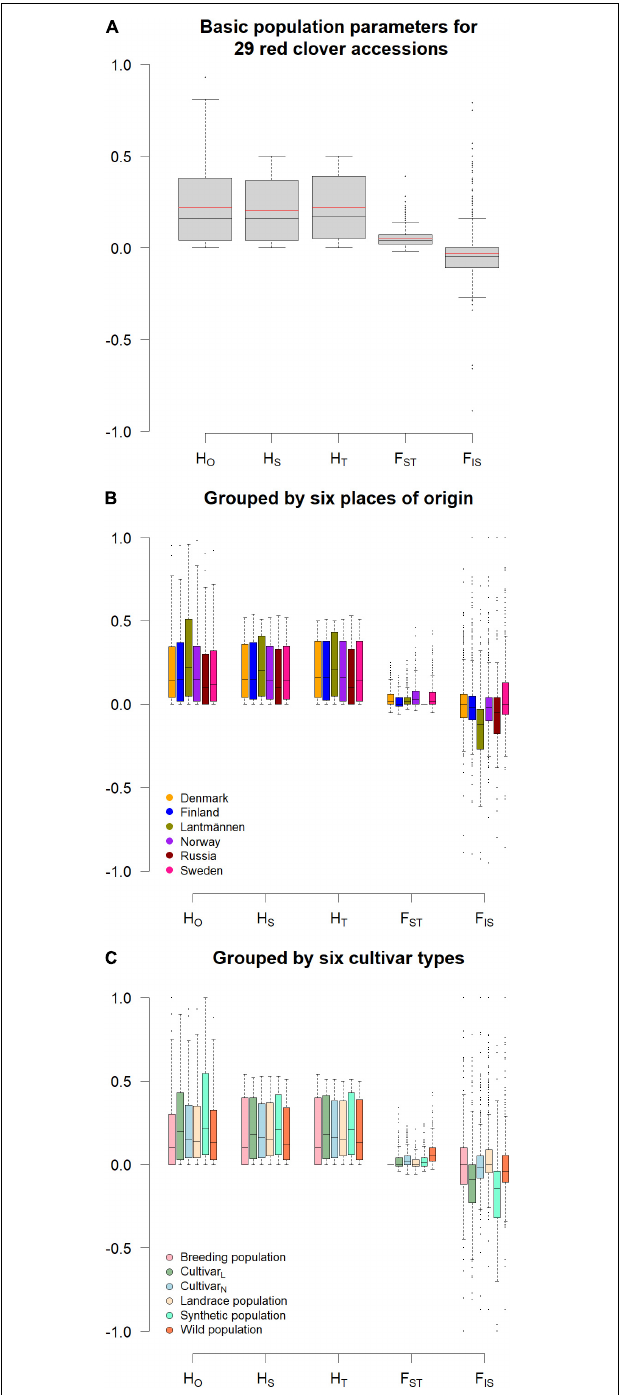
FIGURE 1 | A boxplot visualizing the summary of different population genetics parameters for (A) all accessions, together with a red line marking the mean values, (B) each group of accessions grouped according to their origin, (C) each group of accessions grouped according to their type. The y-axis refers to the range of values for the parameters whereas the different parameters were given along the x-axis. H O = observed heterozygosity; H S = within population gene diversity; H T = overall gene diversity; F ST = population differentiation; F IS = inbreeding